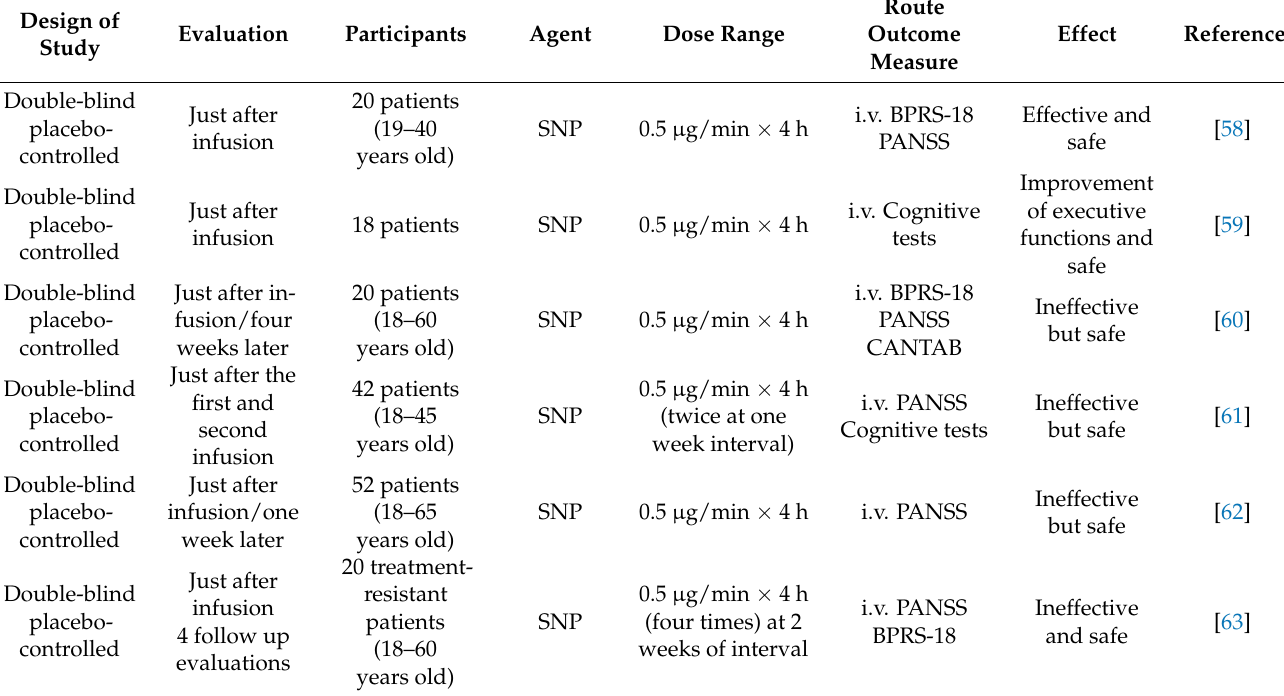
Table 2. Effects of sodium nitroprusside (SNP) in schizophrenia. Clinical